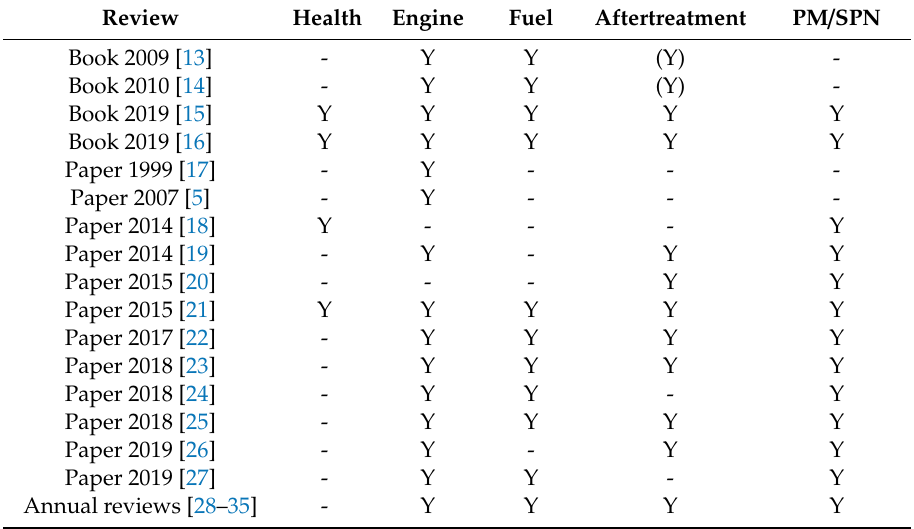
Table 1. Review studies on gasoline engines and their emissions reductions. Y = Yes